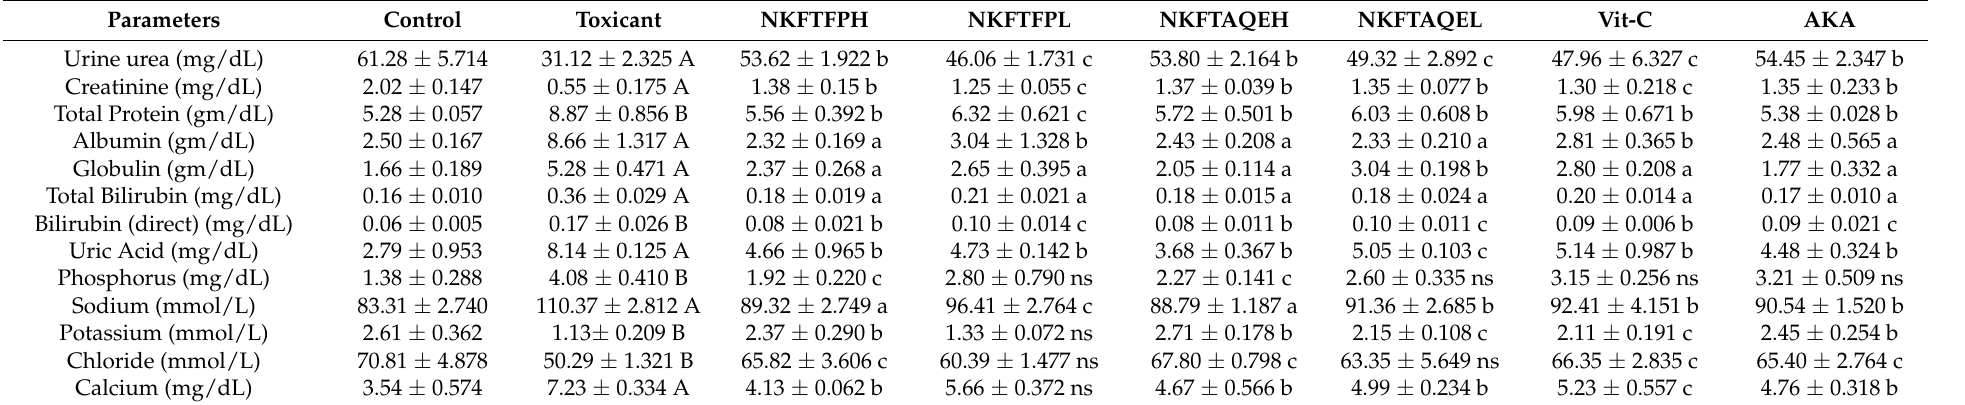
Table 2. Assessment of biochemical markers in urine for the experimental